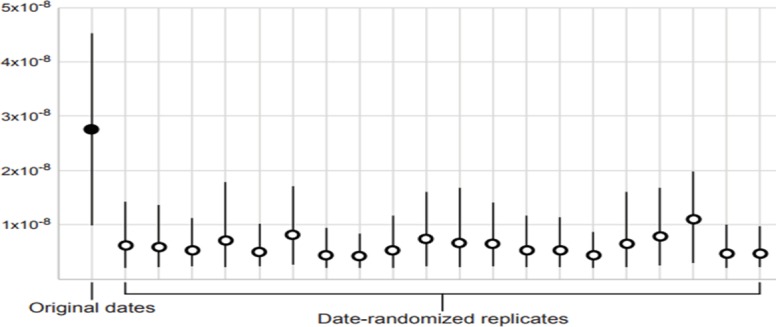
Date-randomisation test for temporal structure in dated mitogenome sequences.The filled circle indicates the median posterior estimate of the mutation rate from the original data set, whereas the empty circles show the median posterior estimates from 20 date-randomised replicate data sets. The 95% credibility intervals (vertical black lines) of the estimates from the date-randomised replicates do not overlap with the median estimate from the original data set, providing some evidence of temporal structure in the data set (criterion CR1). However, the 95% credibility intervals of the estimates from the date-randomised replicates overlap with the 95% credibility interval of the estimate from the original data set, indicating that the data set does not meet the more stringent criterion CR2.